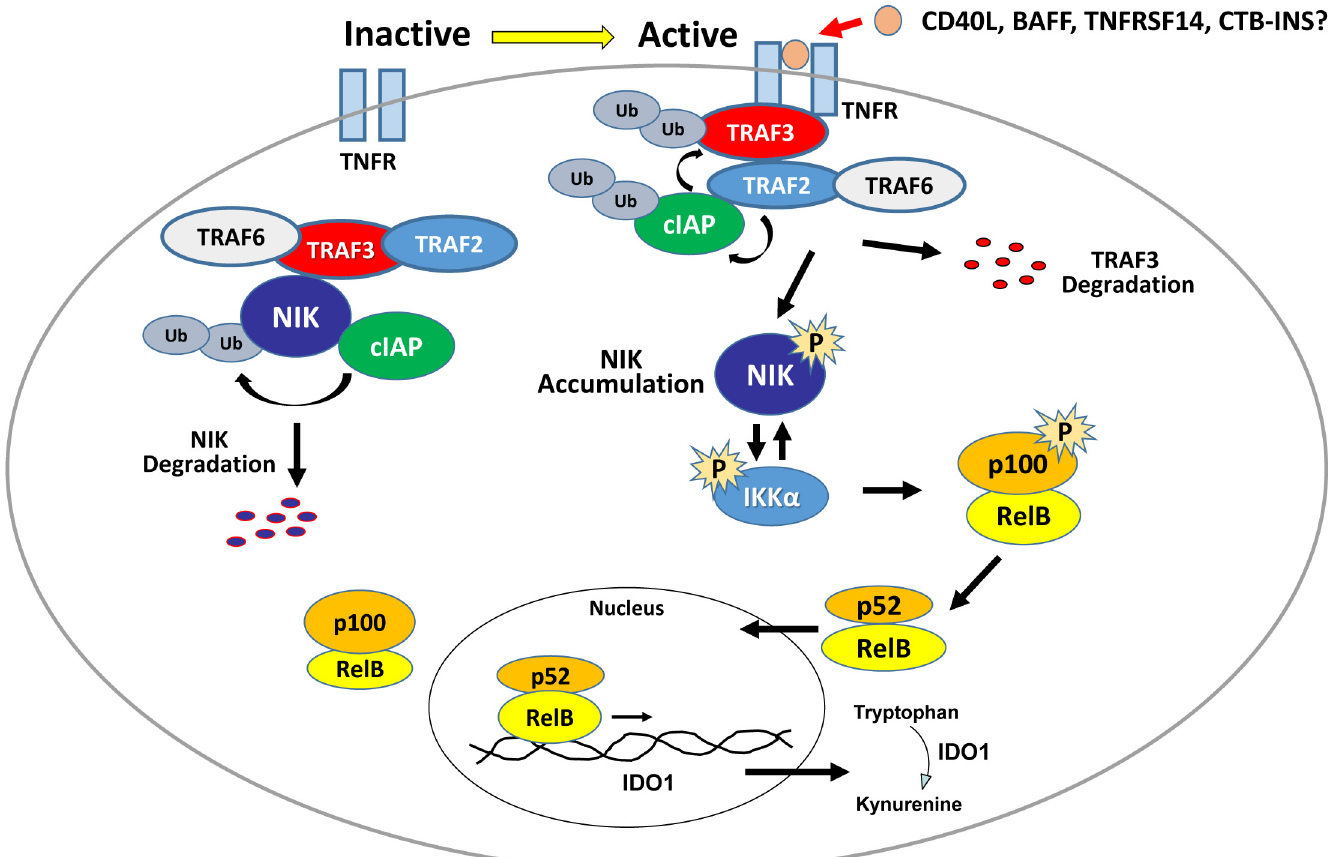
Fig 5. Activation of the non-canonical NF- κ B pathway. In the basal inactive state (left), the TRAF-cIAP complex catalyzes ubiquitination of NIK, leading to constitutive NIK degradation in the proteasome leaving p100-containing RelB complexes isolated in the cytoplasm. During activation (right), the TRAF-cIAP complex is recruited to the CD40 receptor. Upon ligand binding, TRAF2-mediated, ubiquitination of cIAP1/2 switches its ubiquitin ligase activity from NIK to TRAF3. The resultant TRAF3 degradation destabilizes the TRAF-cIAP complex allowing accumulation of newly synthesized NIK. Phosphorylated NIK then transfers a phosphate to IKK α . Now activated, IKK α phosphorylates p100 leading to its partial proteosomal degradation releasing p52: RelB heterodimers that translocate into the nucleus. Further, activated IKK α phosphorylates NIK, destabilizing it thereby limiting downstream activation